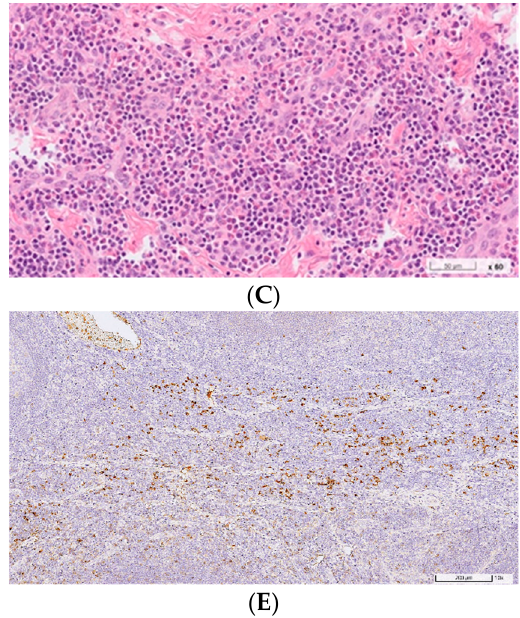
Figure 3. Pathological features with hematoxylin-eosin stain and immunohistology stain of the specimen from Case 2. ( A ) Foci of fibrosis, fibroadipose tissue, and salivary gland tissue with scattered lymphoid follicles containing germinal centers, 2 × . ( B ) Small blood vessel infiltration. ( C ) Dense infiltration of small lymphocytes, plasma cells, and eosinophils, 60 × . ( D ) Immunohistology stain showed IgG4-positive cells, more than 100 cells per high-power field ( E ) Immunohistology stain showed IgG-positive cells, percentage of IgG4-positive/IgG-positive cells was more than 40%.